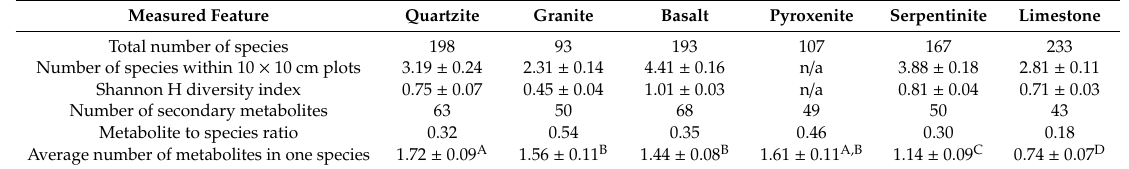
Table 3. Species and secondary metabolite diversity on di ff erent rock